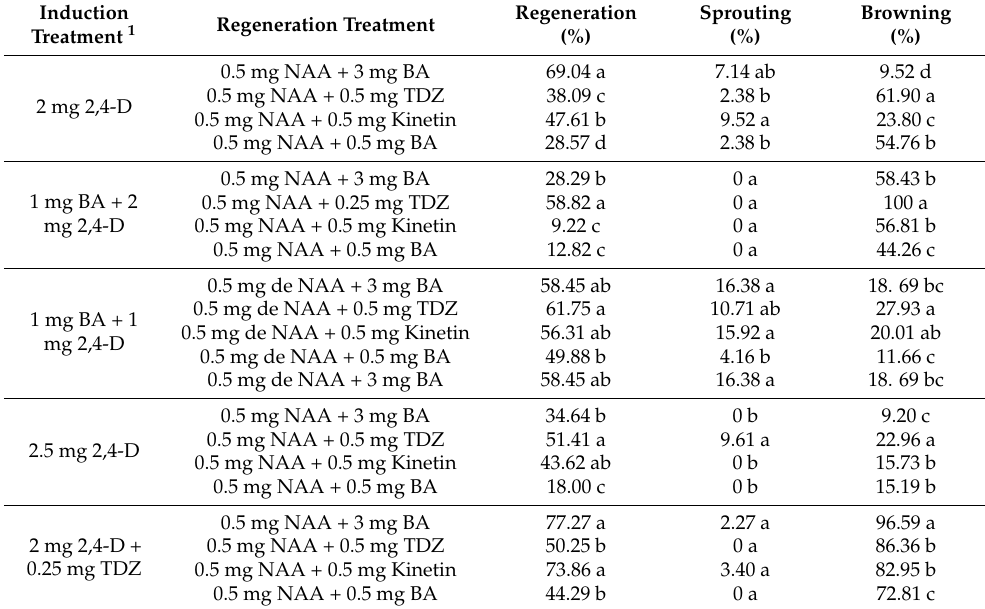
Table 2. Rice calli response of Lazarroz FL cultivar after 4 weeks of culture on different regeneration media.